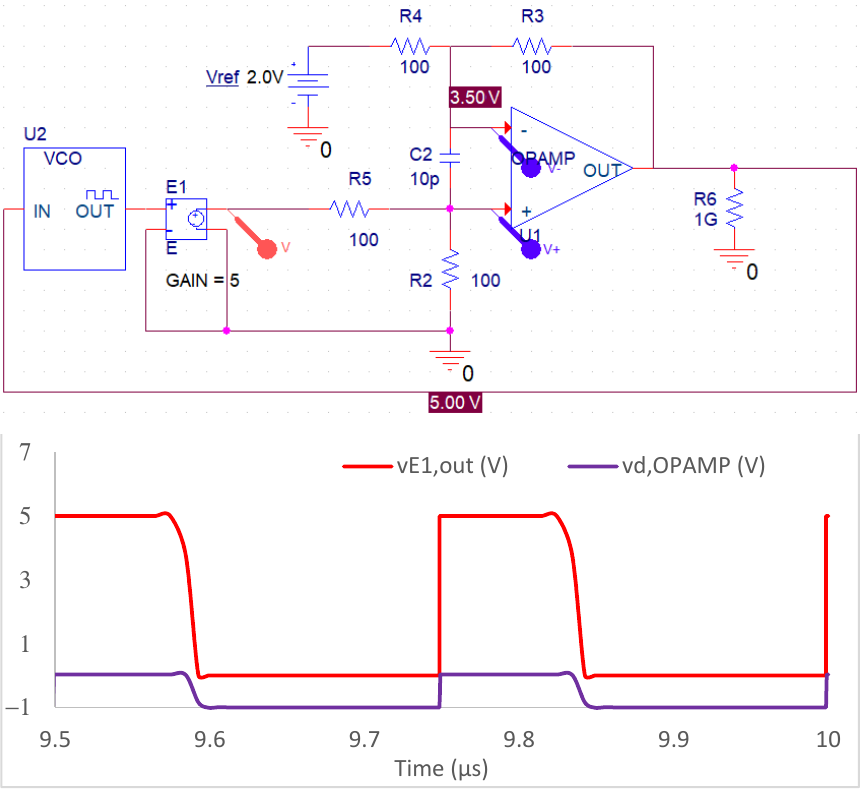
Figure 14. SPICE analysis of VFPWM using dCCDA feedback.